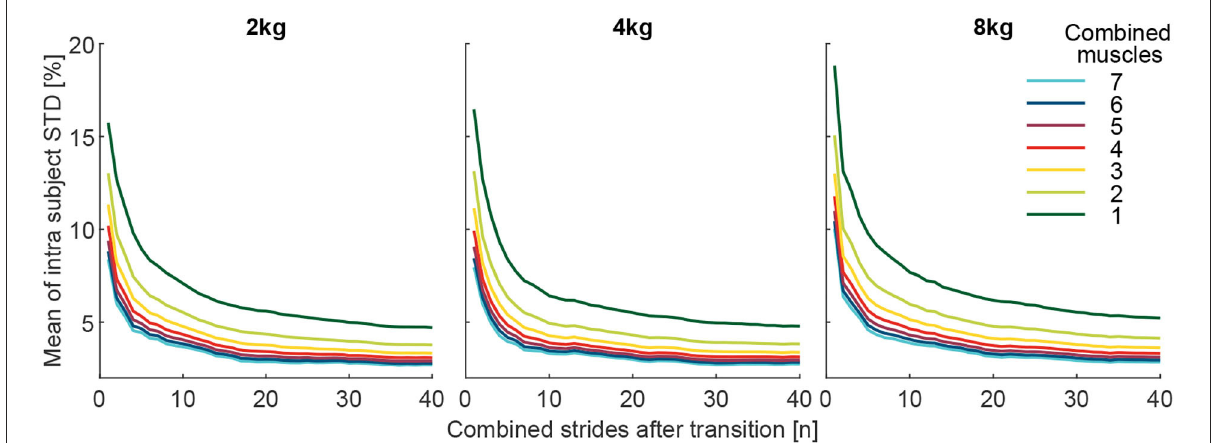
FIGURE11 The Grand mean of the intra-subject SD (MAV i ,std ) of the effort level (MAV stride ) of the comparison condition (above or below the reference of 100%, depending on the condition). The MAV i ,std is shown with respect to the number of involved muscles from the 127 possible muscle combinations analyzed. Each graph includes 40 strides in alternating order from the left (20 strides) and right (20 strides) limbs. For example, the dark green curve is the mean of the seven individual muscle analyses, and the light green is the mean of the 21 possible two-muscle combinations. Furthermore, all combinations with 3 (yellow, 35 comb.), 4 (red, 35 comb.), 5 (purple, 21 comb.), 6 (blue, 7 comb.), and 7 (cyan, 1 comb.) involved muscles were analyzed.